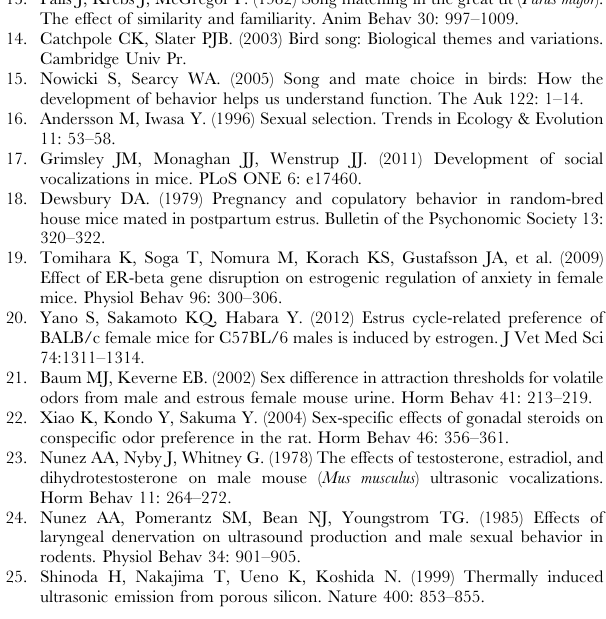
Figure S3 In the presence of female odor stimuli, female mice did not show a preference for songs of males of a different strain. Duration of time searching during diestrus in B6 ( n = 5) and BALB ( n = 7) females exposed to female odor for 15 min before testing. Female-soiled bedding contained a mixture of 2 g each from adult B6 and BALB/c females. No significant differences were observed. (TIFF) Figure S4 Females showed preference for songs pro- duced by different individuals of B6 and BALB males. When songs were recorded from individual B6 and BALB males and played back to a female subject, B6 females ( n =6) showed longer search times for BALB song, and BALB females ( n = 5) showed longer search times for B6 song. Asterisks indicate significant differences p , 0.05. (TIFF) Figure S5 Information about male songs used for each playback test. (a) Principal components in 6 songs used for each playback test. (b) Mean percentage composition of each waveform category in the 6 playback songs.